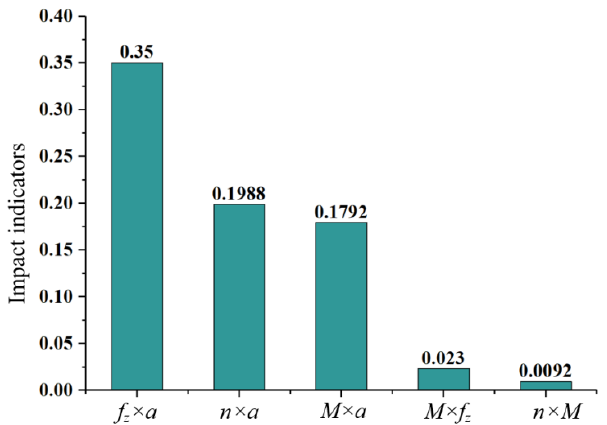
Figure 12. The influence index of machined surface angle error. As shown in Figure 12, the index of interaction between feed per tooth and milling vibration is 0.35, the index of spindle speed and milling vibration is 0.1988, the index of tool tooth error and milling vibration is 0.1792, the index of tool tooth error and feed per tooth is 0.023, and the index of spindle speed and tool tooth error is 0.0092. These results show